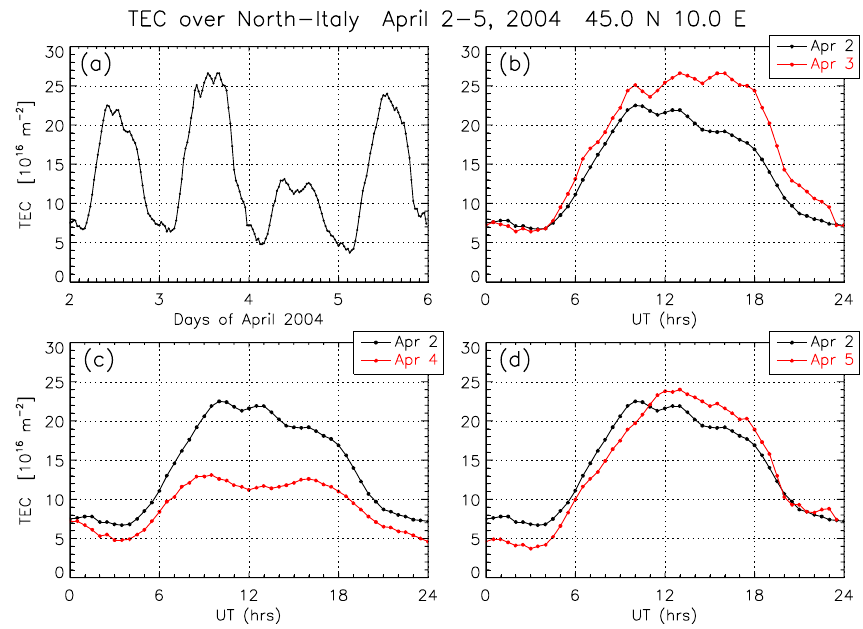
Fig. 8. (a) Vertical TEC measurements deduced from GPS signals using an European network of IGS stations for the time interval 2– 5 April 2004 above Northern Italy at geographic coordinates of 45 ◦ N and 10 ◦ E. In the other panels, the diurnal TEC variation of the geomagnetically quiet day 2 April 2004, is compared with different disturbance phases during the three subsequent days. This comparison shows a positive storm on 3 April, followed by a negative storm phase during about one and a half days on 4–5 April, after which a smaller, positive disturbance re-establishes at about 11:00 UT on 5